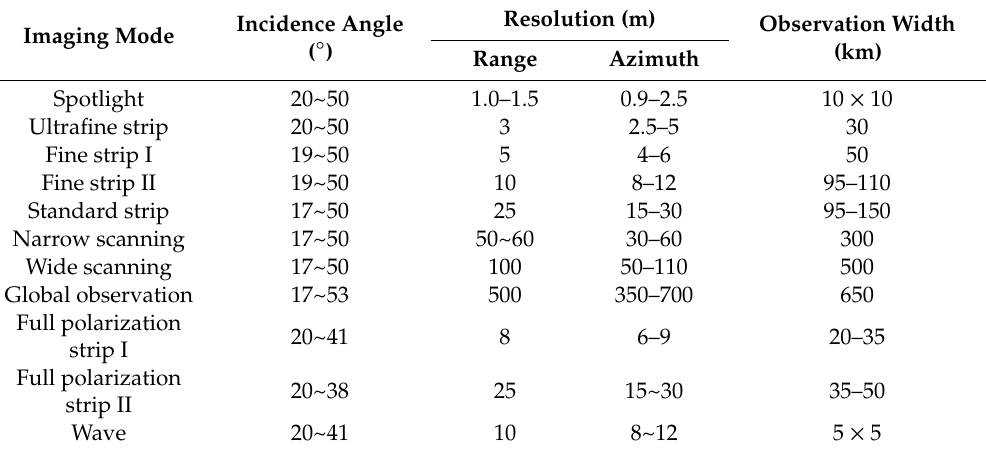
Table 2. Imaging modes and parameters of the Gaofen-3